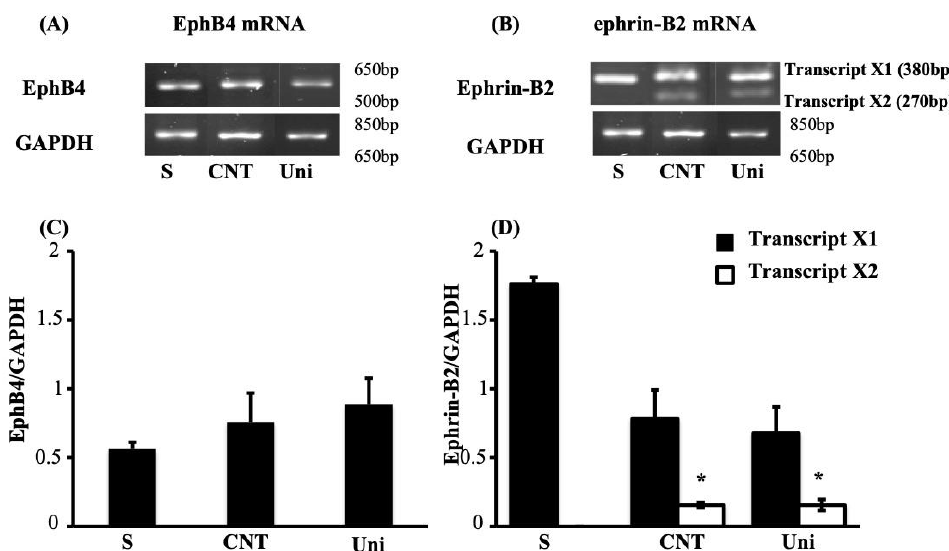
Figure 5. UniPR1331 and EphA2 did not modify colonic levels of EphA2 and ephrin-A1 mRNA. Representative agarose gels showing mRNA levels of EphA2 ( A ), ephrin-A1 ( B ) and GAPDH from the colon of vehicle-treated normal mice (S; n = 5) and of TNBS-treated mice administered with vehicle (CNT; n = 5), EphA2 20 mg/kg (EphA2; n = 5) or UniPR1331 25 mg/kg (Uni; n = 5). Histograms represent the quantification of EphA2 ( C ) and ephrin-A1 ( D ) mRNA levels normalized to GAPDH amplification products. Data are shown as mean ± SEM.